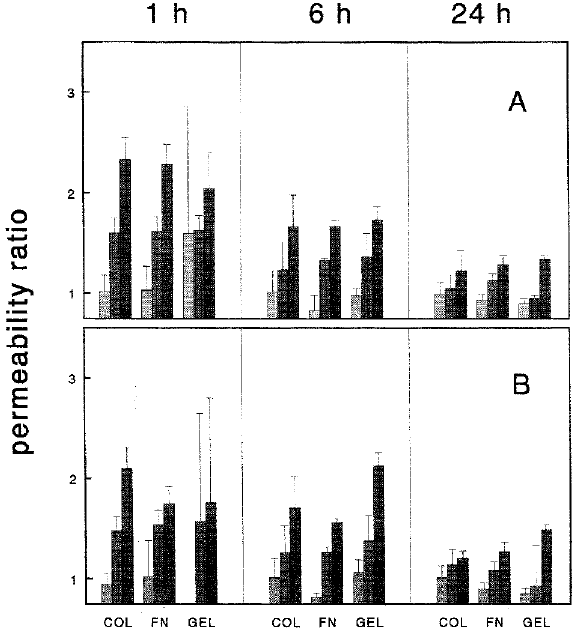
FIG. 4. Permeability of TNF- a -treated HUVEC monolayers. The increase in permeability to albumin (panel A) and dextran (panel B) is expressed as the permeability ratio (± SD, n = 4) between treated and untreated monolayers. In panels, from left to right, the permeability ratio of mono- layers cultured on collagen (COL), fibronectin (FN) and gelatin (GEL), after 1, 6 and 24h of diffusion is shown. Open bars: 50pg/ml TNF- a ; grey bars: 500pg/ml TNF- a ; black bars: 10ng/ml TNF- a